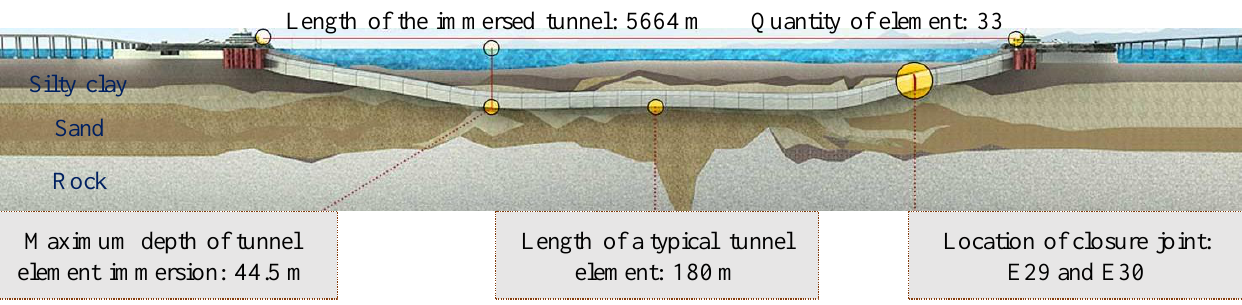
Figure 3. Longitudinal layout of the HZMB immersed tunnel.